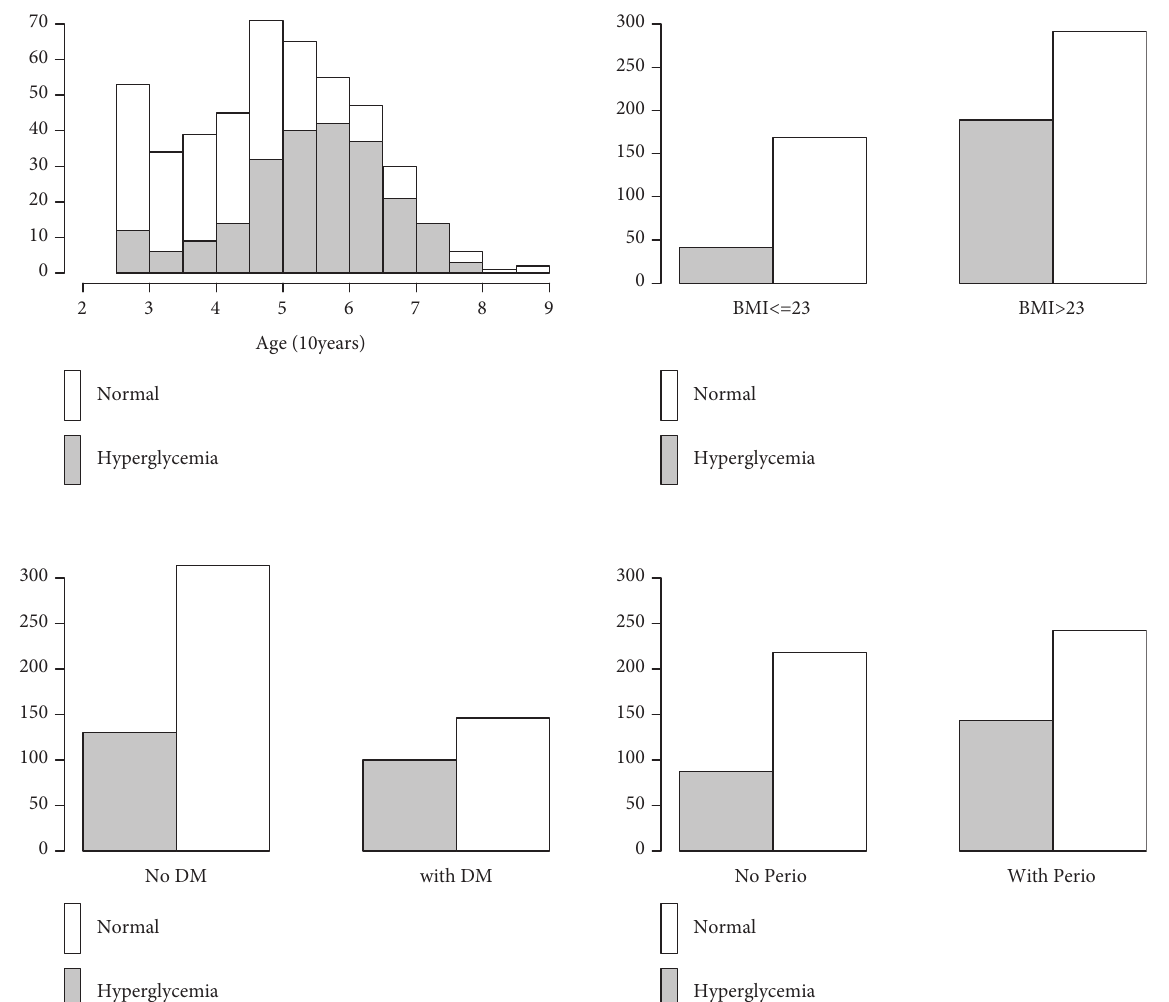
Figure 2: Demographic data of significant variables; age, BMI, family history of DM, and periodontal status, from a study of risk factors associated with hyperglycemia using binary logistic regression analysis [14]. Table 3: Results from a sex determination study by tooth widths using binary logistic regression analysis [20]. Independent variables